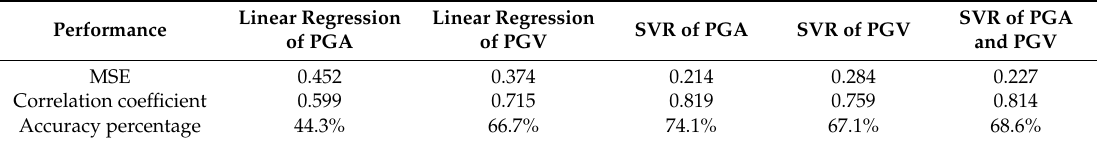
Table 2. Performance measures for Gaussian kernel SVR and the linear regression of peak ground acceleration (PGA) and peak ground velocity (PGV).